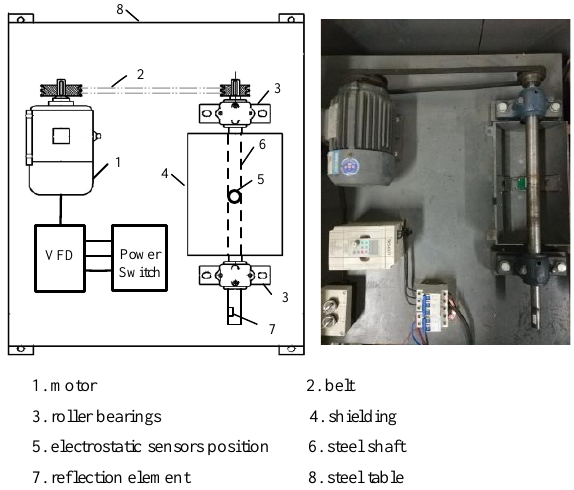
Figure 14. Schematic and photograph of the test rig.